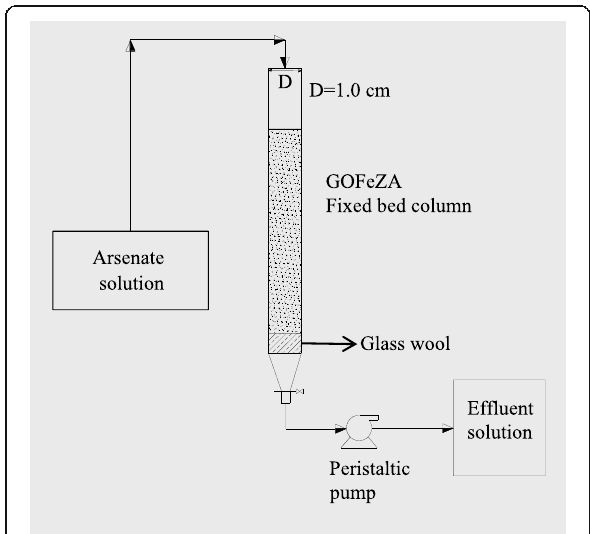
Fig. 1 Schematic diagram of the fixed-bed column